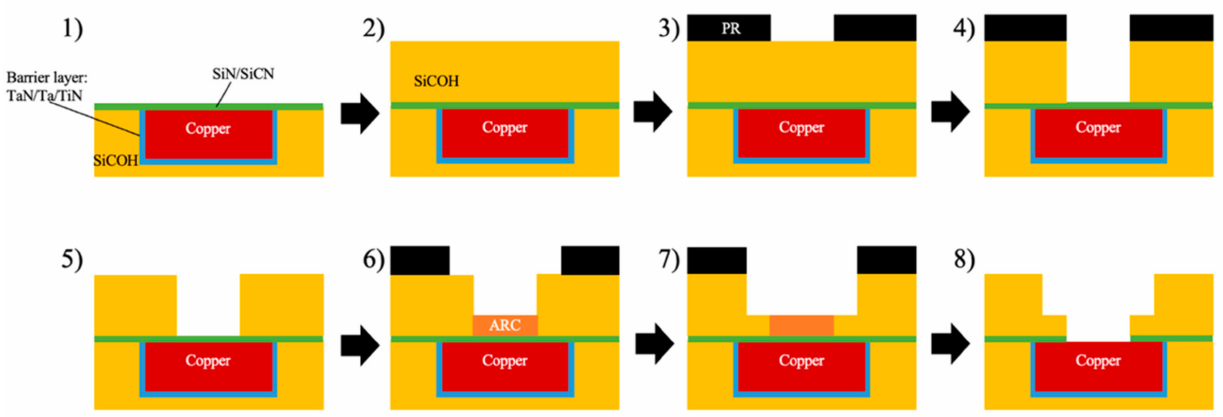
Figure 9. Dual-Damascene process flow for Cu/low-k interconnects